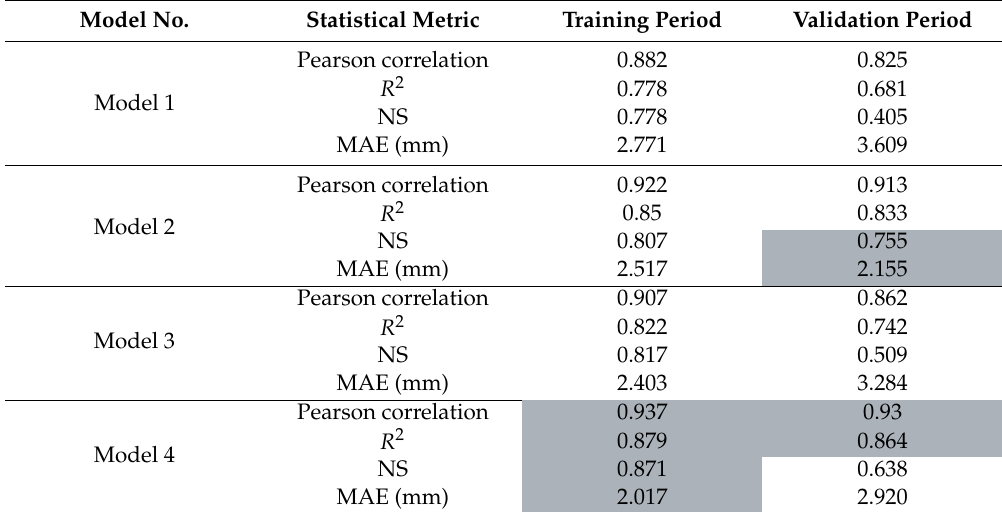
Note: The highlighted values represent the best performing metrics during the training and validation